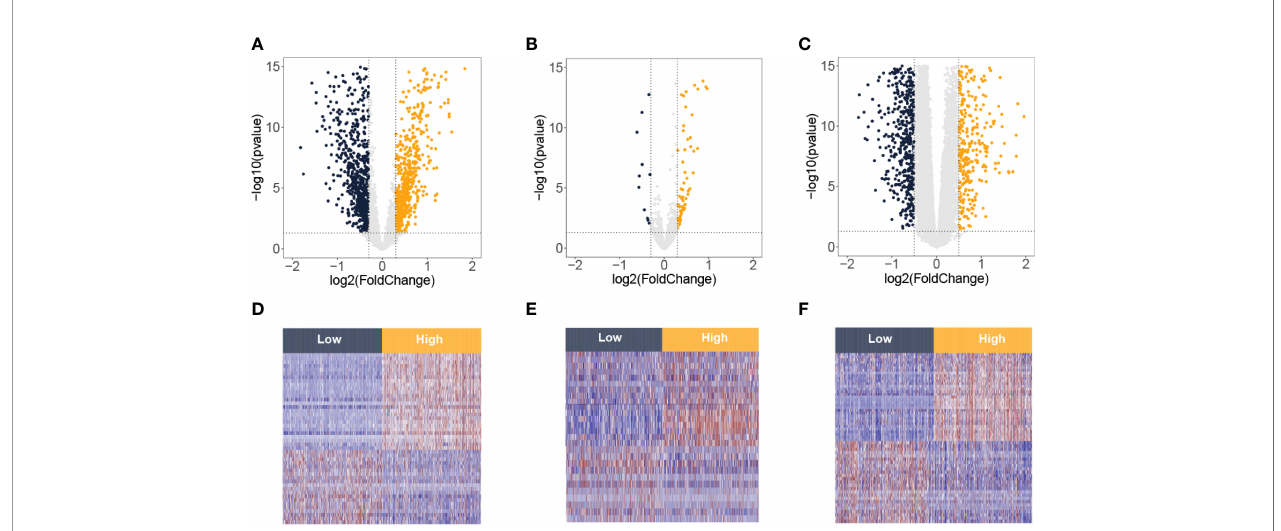
FIGURE 2 | Differentially expressed lncRNA, miRNA, and mRNA between low and high T-cell groups from the TCGA-BRCA database. Volcano plots of differentially expressed lncRNAs (A) , miRNAs (B) , and mRNAs (C) . The red spots on the graphs re fl ect signi fi cantly elevated RNAs, whereas the green ones show signi fi cantly downregulated RNAs in the high T-cell group. Heatmaps of differentially expressed lncRNAs (D) , miRNAs (E) , and mRNAs (F) . The red signi fi es increased expression, whereas the blue signi fi es decreased expression.